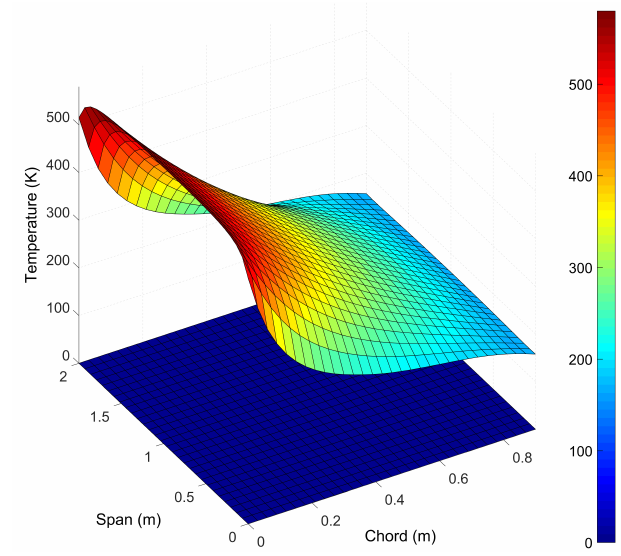
Figure 4. Applied temperature distribution after 1 s simulation